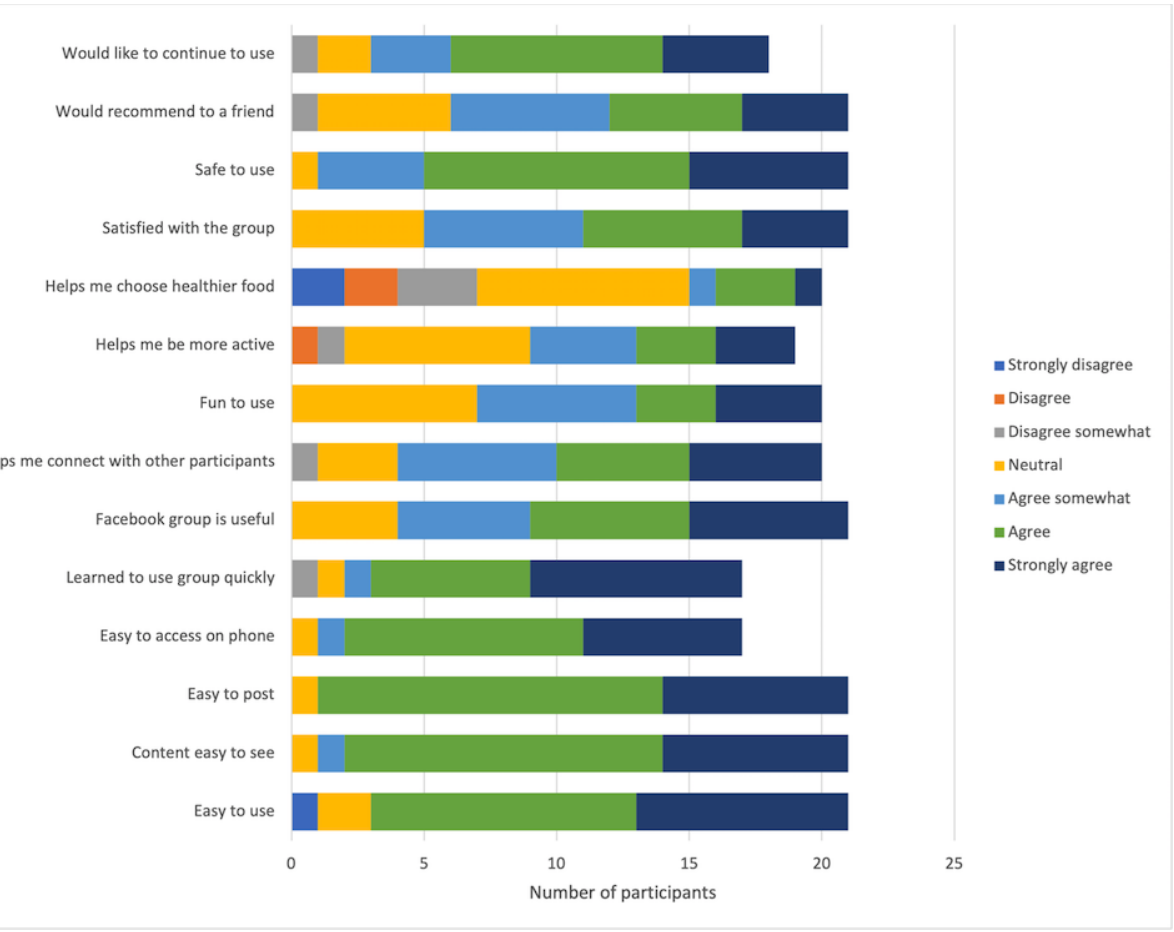
Figure 2. Participant responses to the feasibility and acceptability